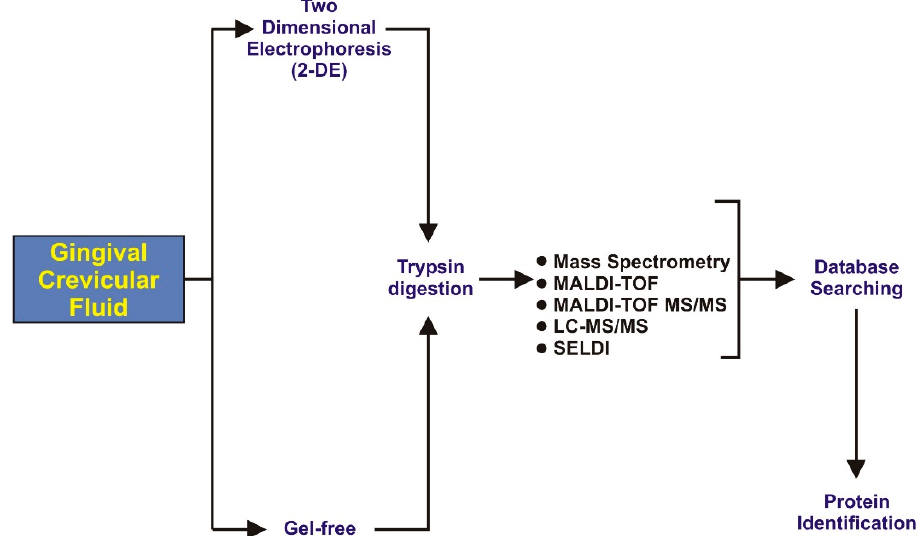
Figure 2. Illustration representing the steps of gingival crevicular fluids (GCF) proteomics